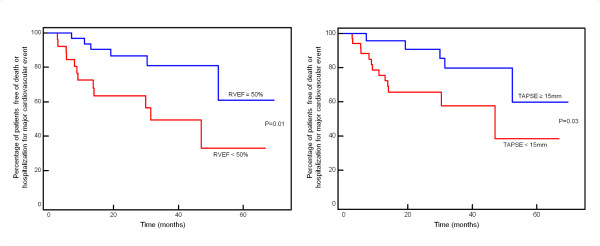
Kaplan-Meier estimates of the time to the primary end-point for RVEF (left panel) and TAPSE (right panel).